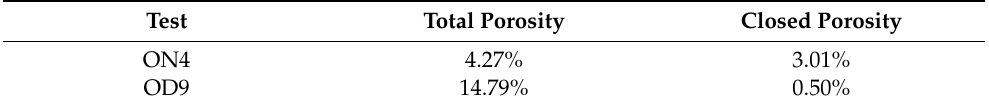
Table 3. Data from Micro-CT (Bruker Skyscan) after test.